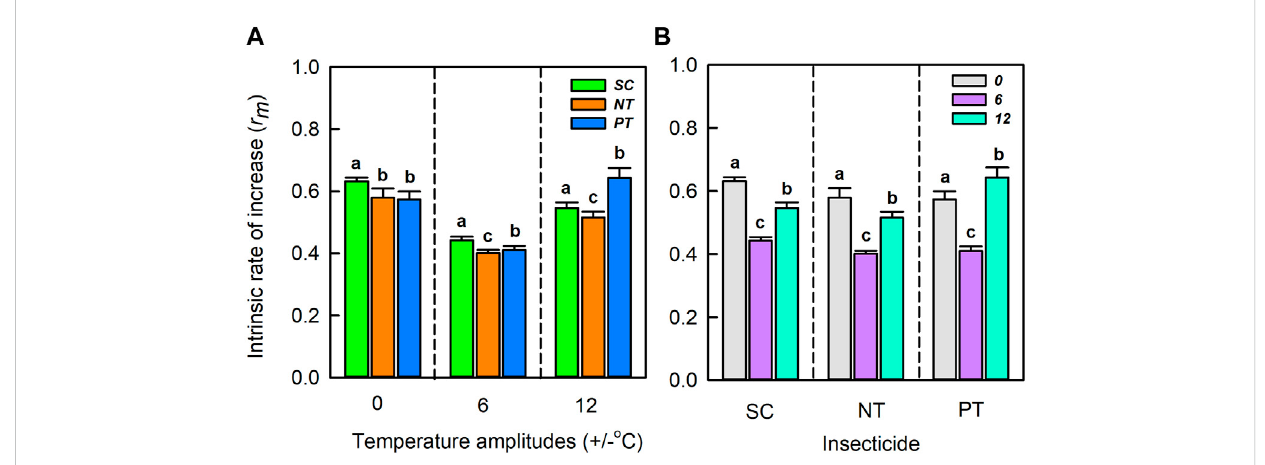
FIGURE 6 The Intrinsic rate of increase (mean ± SD) under temperature amplitudes (A) and insecticides (B) . Different lowercase letters represent signi fi cant differences between different treatments at the p = 0.05